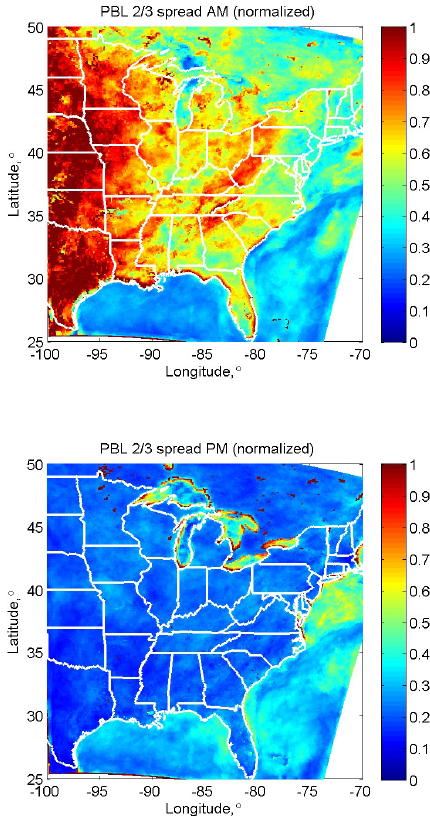
Figure 7: Spread of boundary layer height (mixing height) in the early morning and midday as interpreted by FLEXPART-WRF from the WRF ensemble input. Spread is normalized by the mean value.